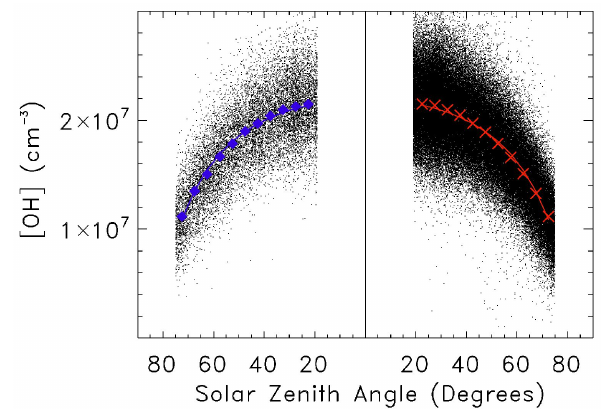
Fig. 1. Mean OH concentrations measured by MLS during the pe- Figure 1: Mean OH concentrations measured by MLS during the period July- riod July–September 2006, obtained within SZA range of 20–25 ◦ (solid) and 65–70 ◦ (dotted curve), plotted as a function of pressure September 2006, obtained within SZA range of 20-25 o (solid) and 65-70 o (dotted curve), (left axis) and approximate altitude(right axis). plotted as a function of pressure (left axis) and approximate altitude(right axis).